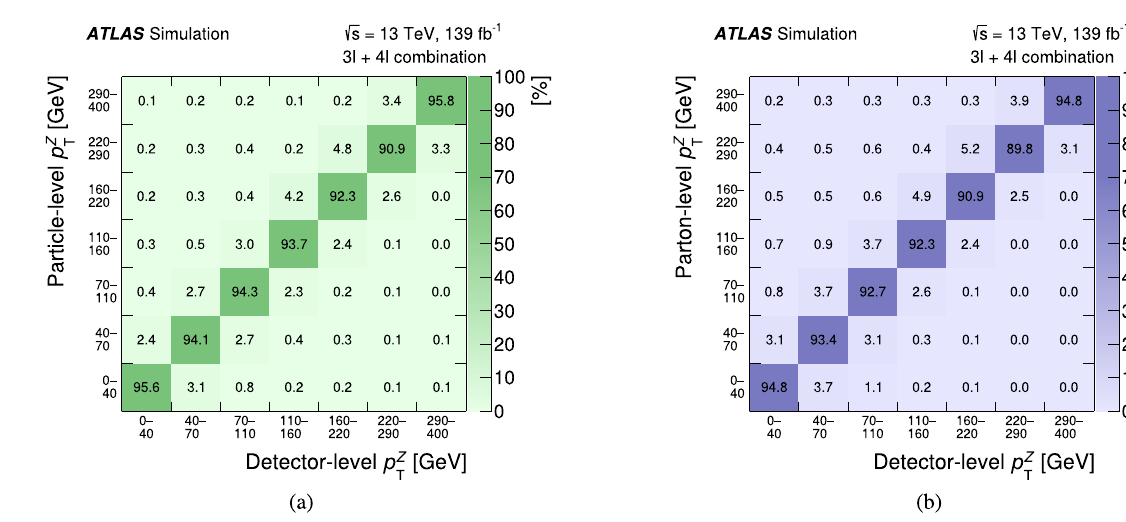
Fig. 7 The migration matrices for the p T of the Z boson in the combi- nation of thetrileptonand tetraleptonregions. The matricesquantify the migrationsfrom a particleor b partonleveltodetectorlevel.Thequoted